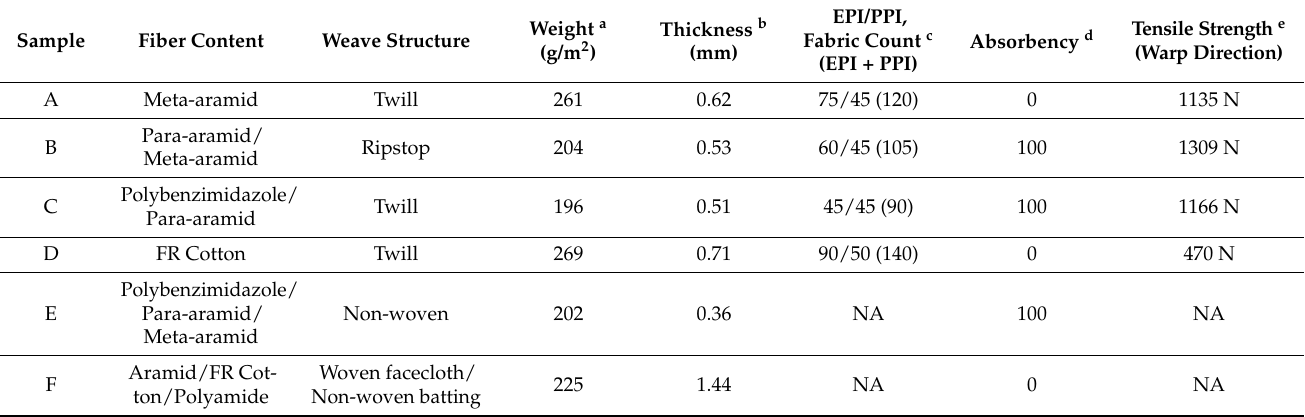
Table 1. Properties of the high-performance fabrics experimented.